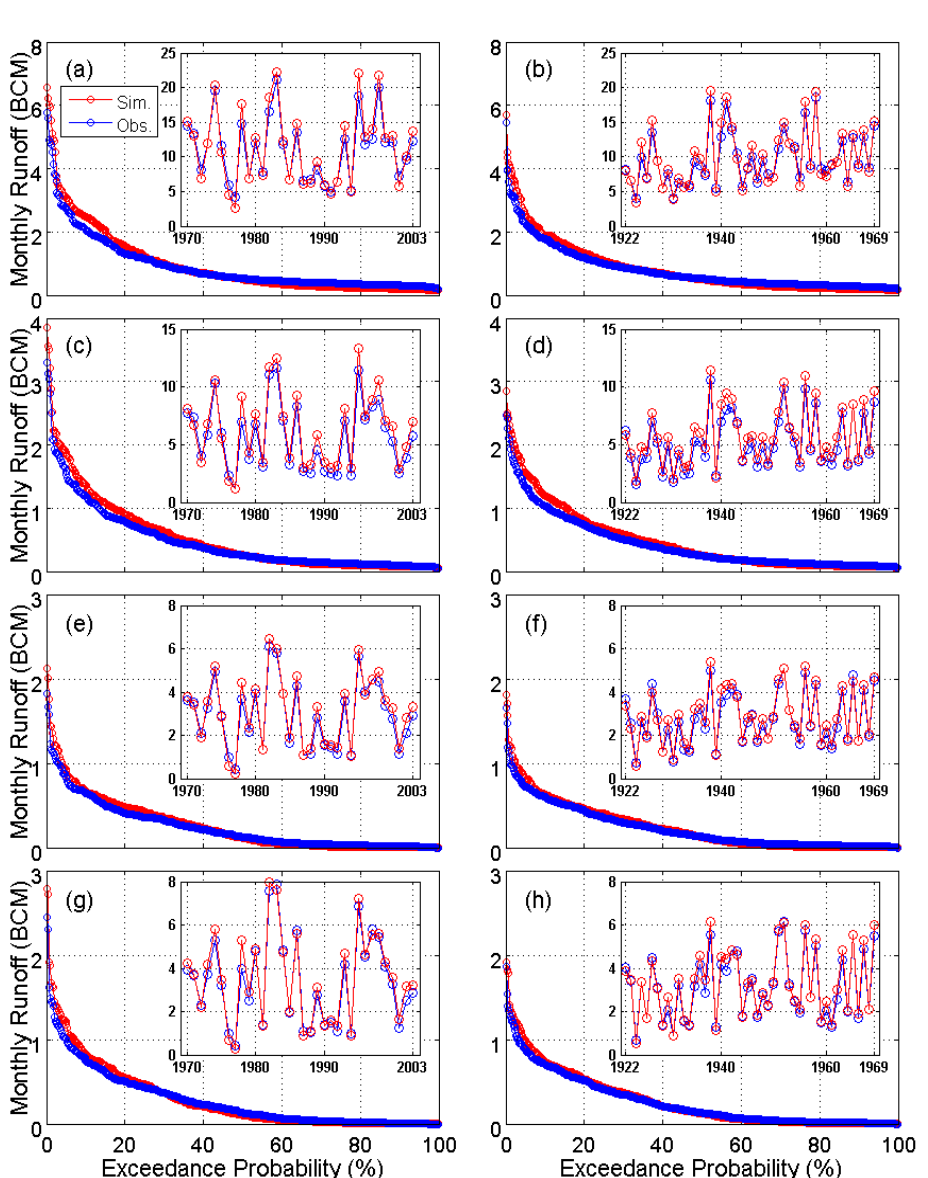
Figure A1. Exceedance probability (%) of simulated and observed monthly runoff (billion cubic meter (BCM)) during the calibration period (first column) and validation period (second column) for watersheds: Sacramento River above Bend Bridge (SBB; a, b ), Feather River (FTO; c, d ), Yuba River (YRS; e, f , and American River (AMF; g,h ). The insert plots show corresponding simulated and observed annual runoff (vertical axis; in BCM) during the calibration or validation period (horizontal axis; in water year).